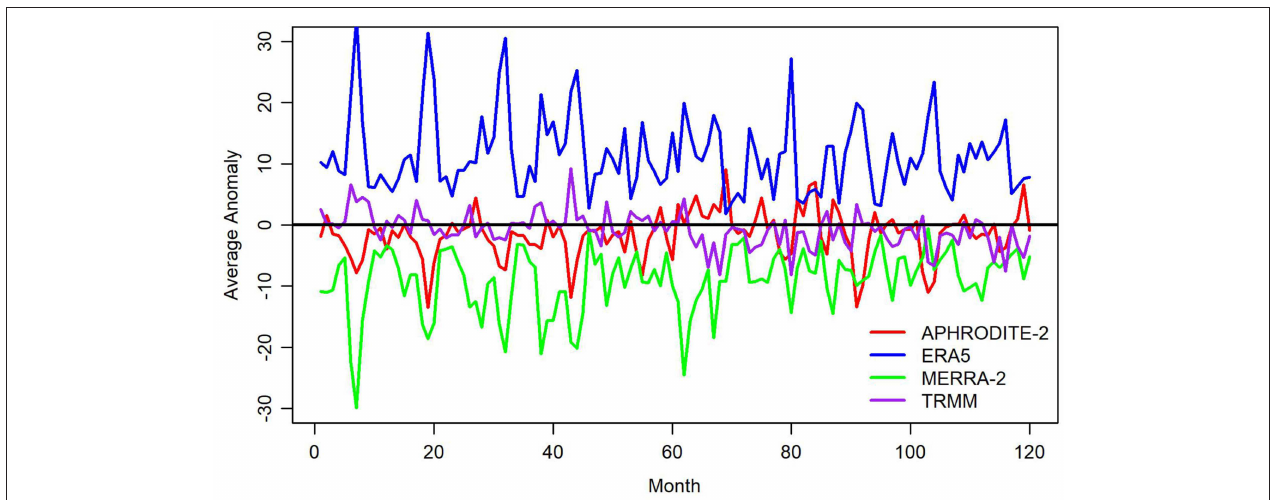
FIGURE 1 | Average monthly anomaly (deviation from mean of all products) in precipitation (in mm) for Indus Watershed region for APHRODITE-2, ERA5, MERRA-2, and TRMM. Month 1 corresponds to January